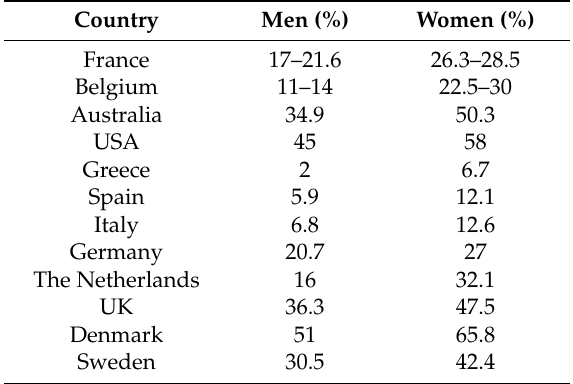
Table 1. Comparison of food supplement consumption between men and women by country [12]. Country Men